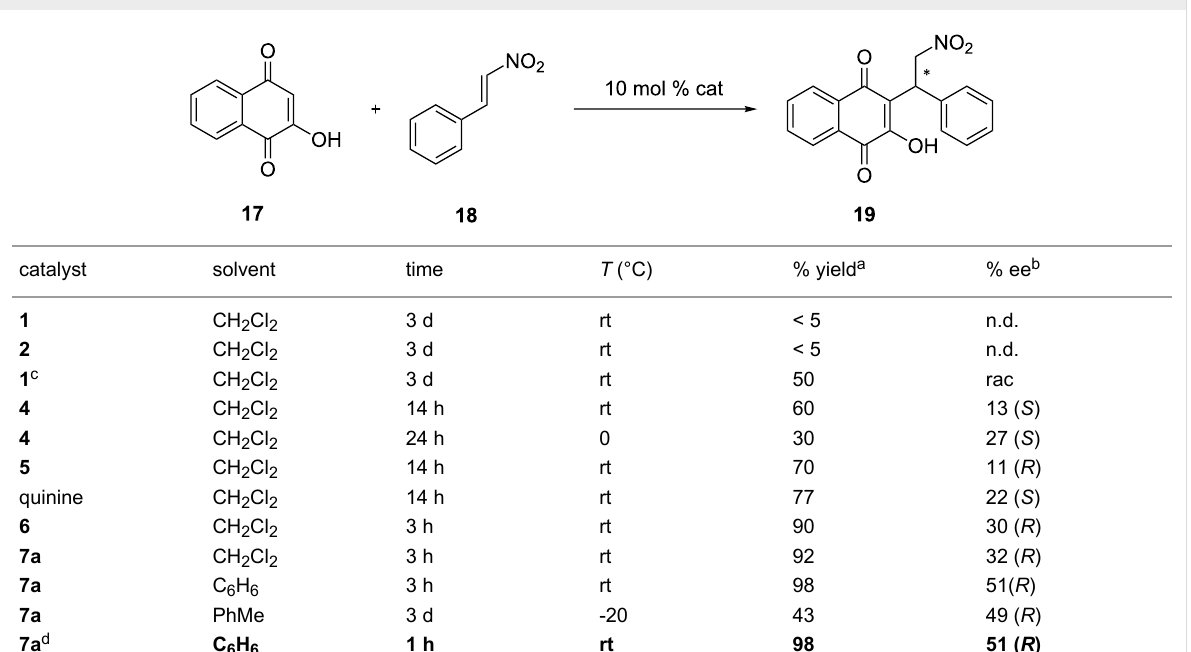
Table 2: Evaluation of open-chain phosphorus-triamide catalysts 1 – 7a (cf. Scheme 1).